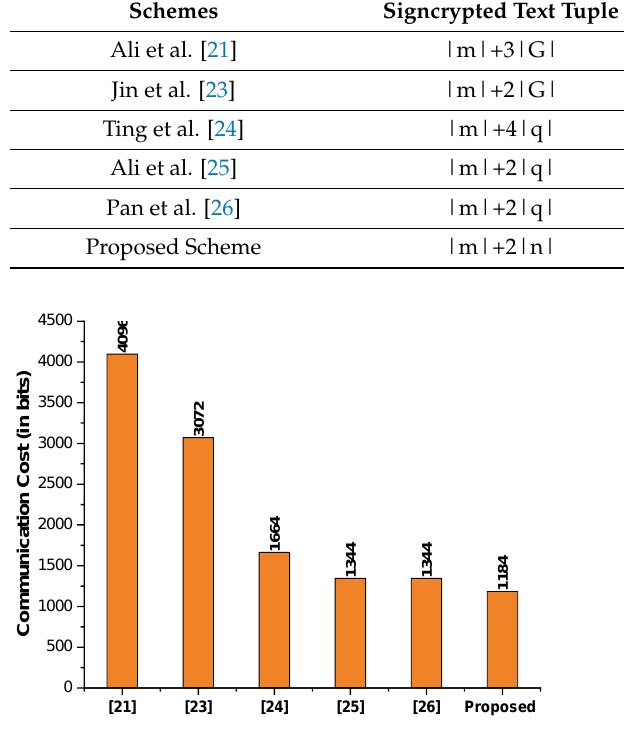
S c h e m es Figure 3. Comparison of communication costs (in Figure 3. Comparison of communication costs (in bits). Table 5. Comparison of communication costs (in bits).